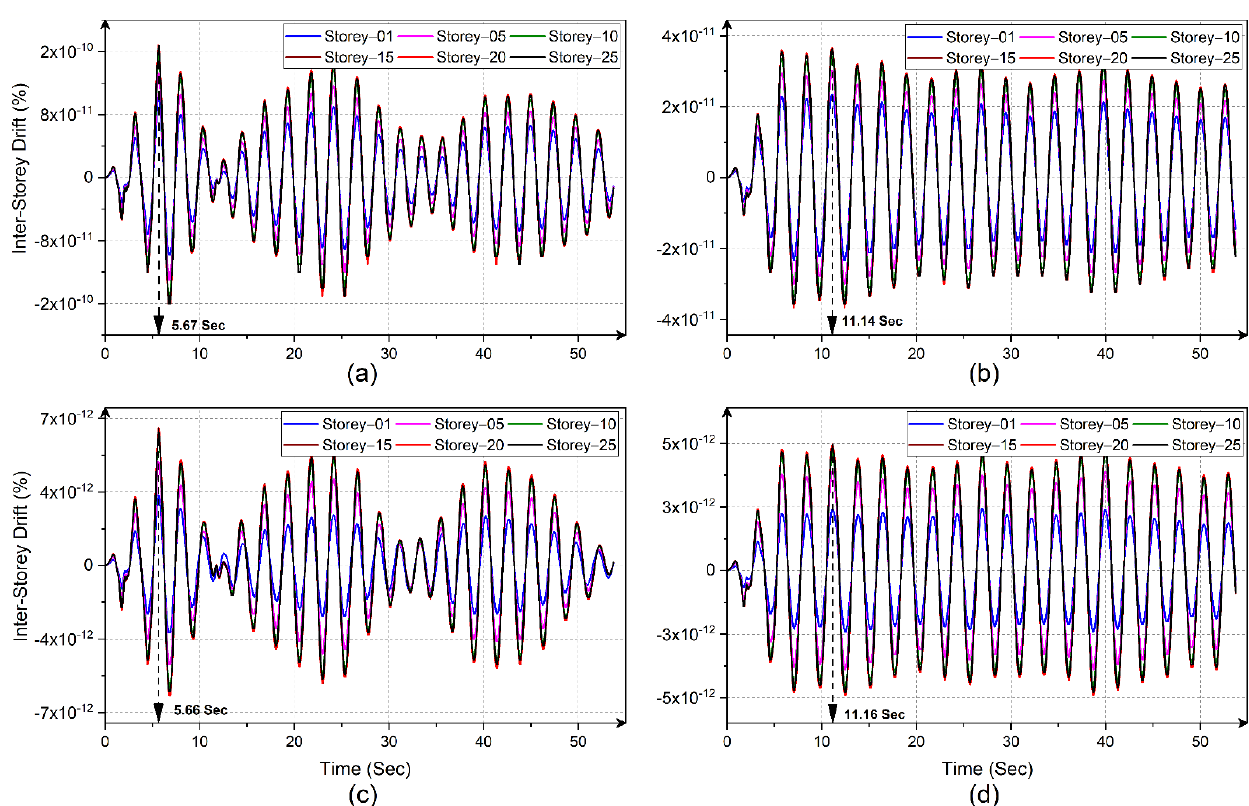
Figure 11. Time – history plots for the inter-story drifts of various floor levels for the structure resting on FP-Mats of different fin-lengths: ( a ) L f = 0.2L p ; ( b ) L f = 0.4L p ; ( c ) L f = 0.6L p ; and ( d ) L f = 0.8L p .